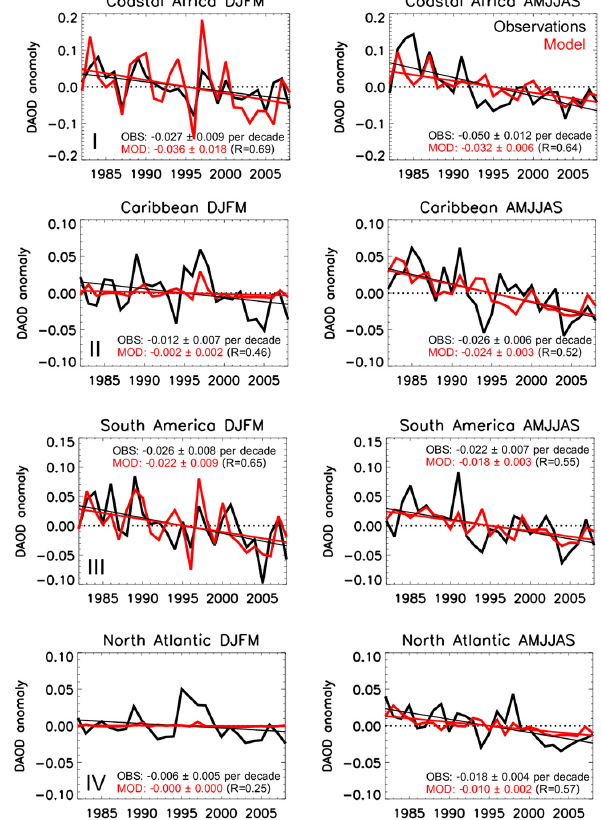
Figure 3. Seasonal DAOD anomalies derived from AVHRR PATMOS-x (black) and from the model (red) are displayed for four regions (roman numerals relate to the locations shown in Fig. 2). Trend lines are plotted as solid lines and the trend and one stan- dard deviation uncertainty shown in each panel for the observations (OBS) and the model (MOD). The correlation ( R ) between model and observations is shown in